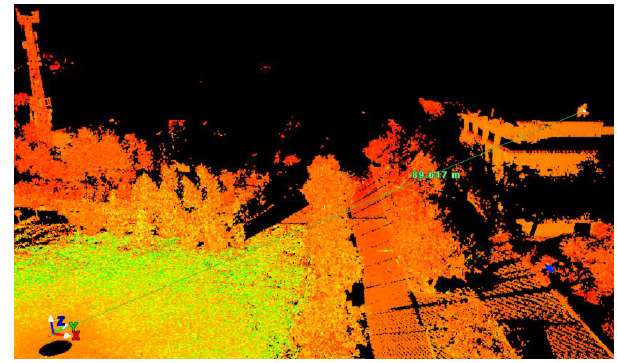
Figure 6: Distance from scanner to satellite dish The model of satellite dish created from scans in daylight conditions consisted of 1474 points while the model obtained from night measurements consisted of 1471 points. Furthermore significant change between day and